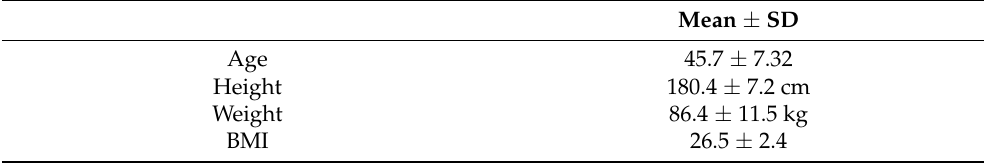
Table 1. Participants anthropometric parameters ( n = 49).